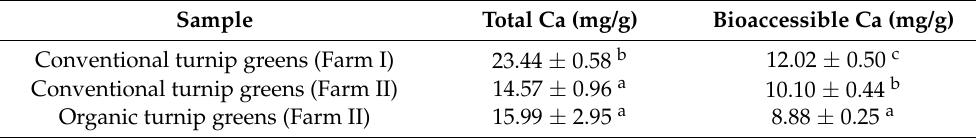
Table 3. Ca total and bioaccessible (mg/g dry weight) in turnip tops (mean ± standard deviation). Sample Total Ca (mg/g) Bioaccessible Ca (mg/g) Conventional turnip tops (Farm I) Conventional turnip tops (Farm II) Organic turnip tops (Farm